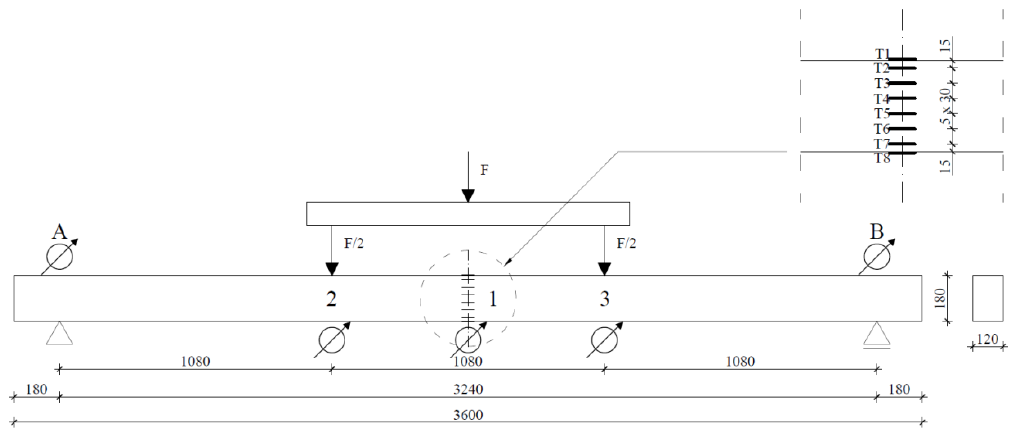
Figure 13. Scheme of the experimental testing site showing locations of the strain gauges.